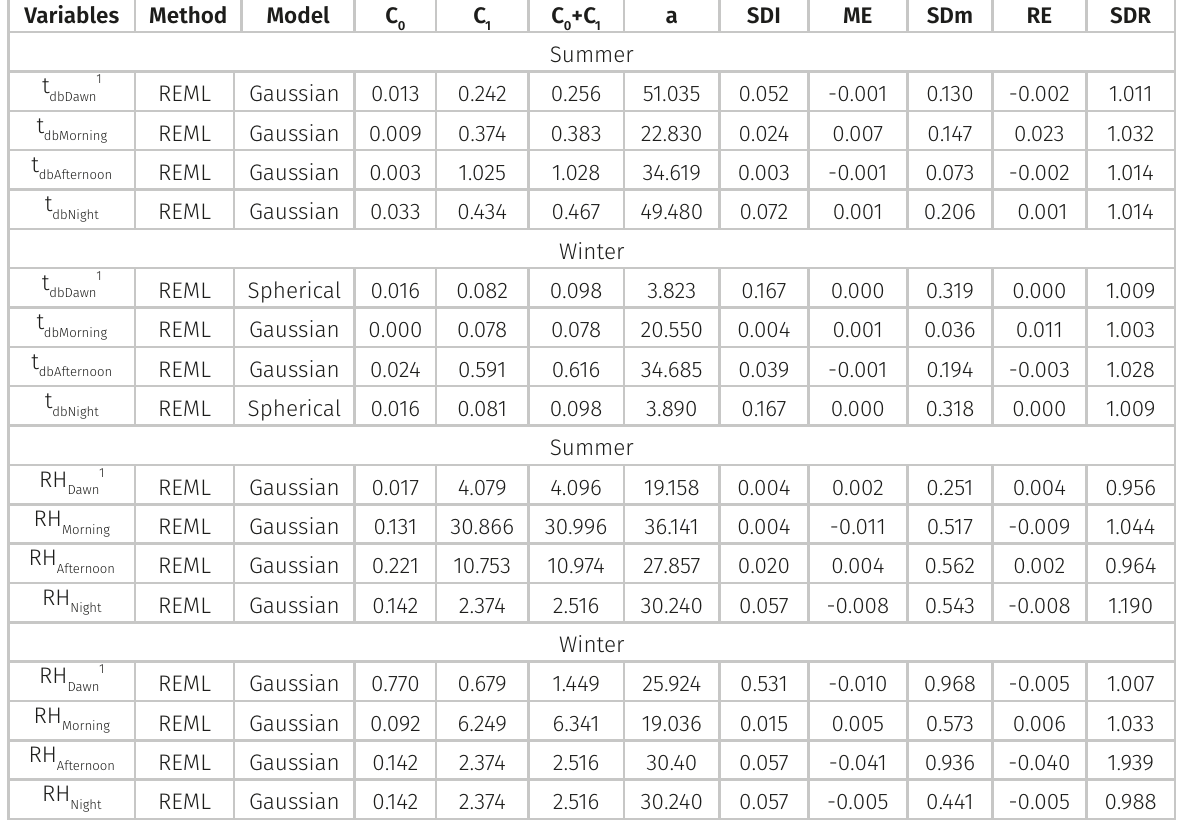
Table I. Method, model, and estimated parameters of the experimental semivariogram for the mean values of each period for the variables air dry-bulb temperature (t ,°C) and air relative humidity (RH, %) inside the compost- db bedded pack barn (CBP) during the winter and